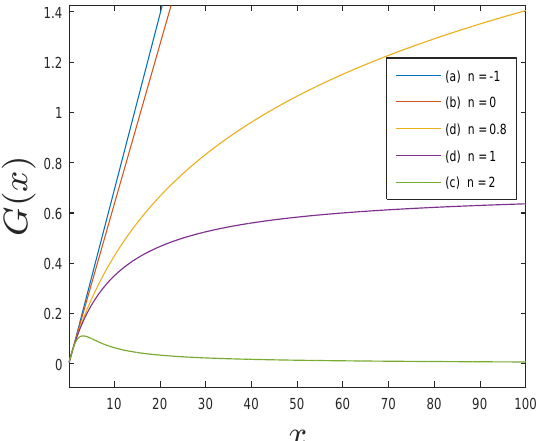
Figure 1. Rate of mass gain as a function of size of the plant, considering the following parameter values: ϑ = 0.07 and g = 0.1. This figure shows that for values of n ≤ 0 (blue, red; cases (a), and (b)), the gain in dry matter grows rapidly (monotonous growth). Similarly, for n = 2 (green; case (c)), the dry matter gain falls very quickly to zero. For values of n = 0.8 (yellow, case (d)) and n = 1.0 (purple; case (d)) the behavior of the gain is more realistic. In this work, a value of n = 1 was assumed for the model.